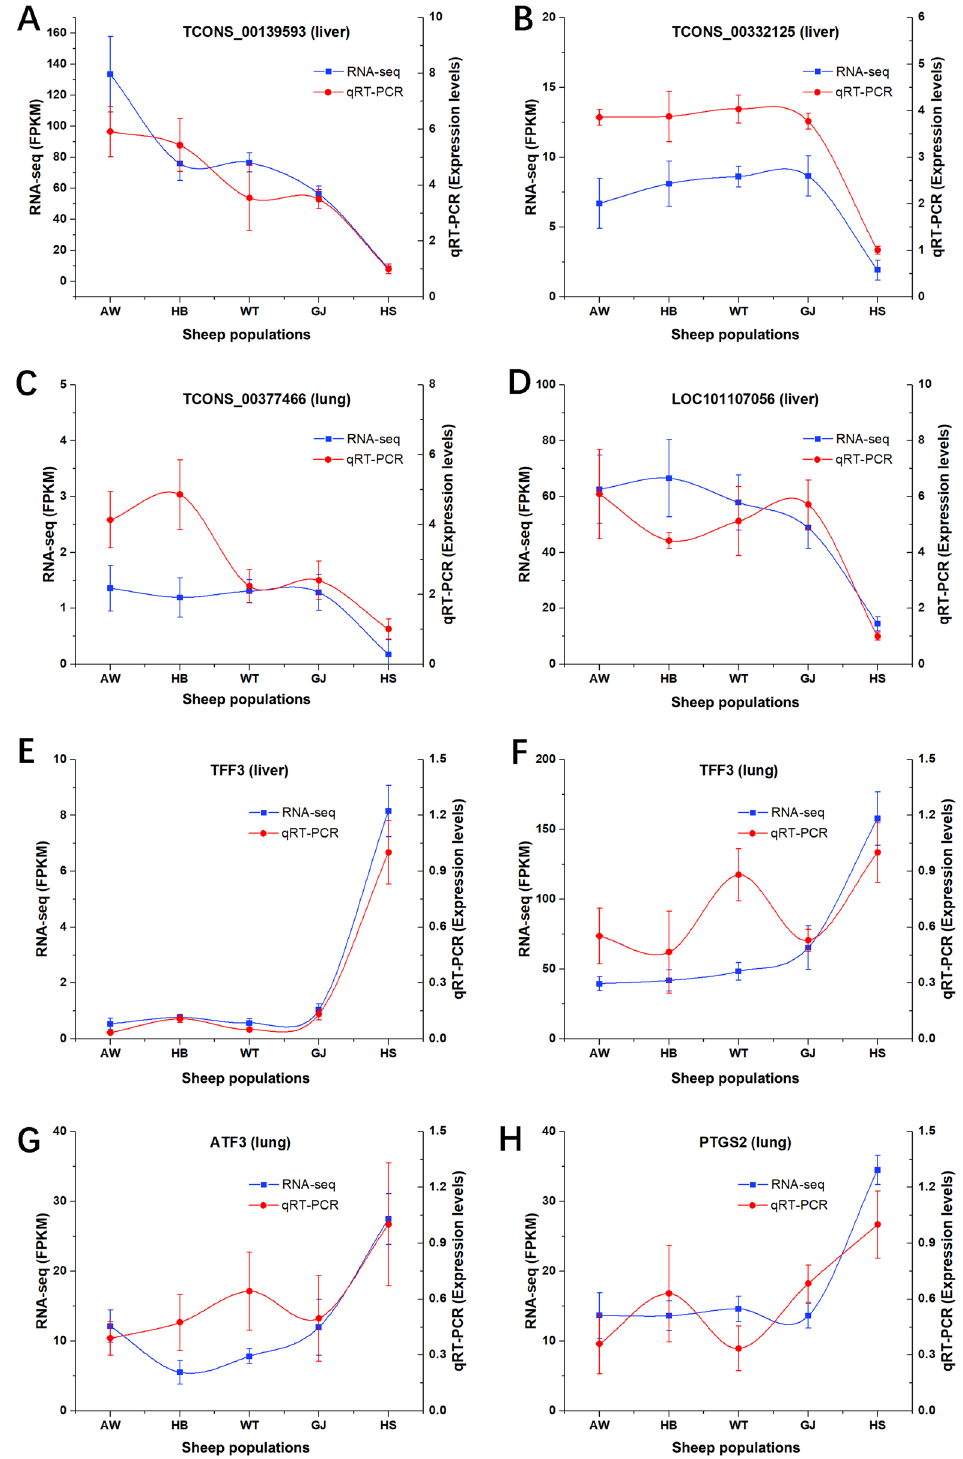
Figure 5. Confirmation of expression patterns of the eight selected differential expression genes using qRT-PCR. The trends of qRT-PCR results are consistent with RNA-seq data. ( A ) The common DE lncRNA TCONS_00139593 in five sheep populations of liver samples (AW, HB, GJ, WT, HS). ( B ) The common DE lncRNA TCONS_00332125 in five sheep populations of liver samples. ( C ) The common DE lncRNA TCONS_00377466 in five sheep populations of lung samples. ( D ) The common DE lncRNA TCONS_101107056 in five sheep populations of liver samples. ( E ) The common DE mRNAs TFF3 in five sheep populations of liver samples. ( F ) The common DE mRNAs TFF3 in five sheep populations of lung samples. ( G ) The common DE mRNAs ATF3 in five sheep populations of lung samples. ( H ) The common DE mRNAs PTGS2 in five sheep populations of lung